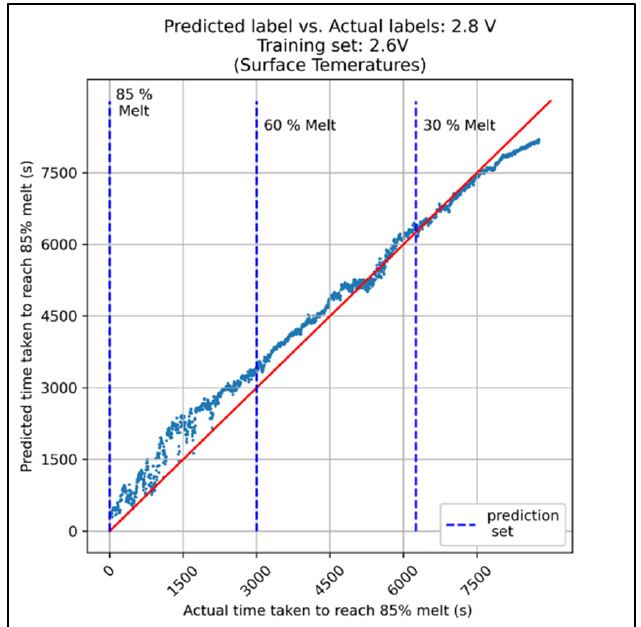
Figure 14. Scatter plot comparing the predictions of the ANN trained on surface temperatures with